Question: Name the type of graph shown.
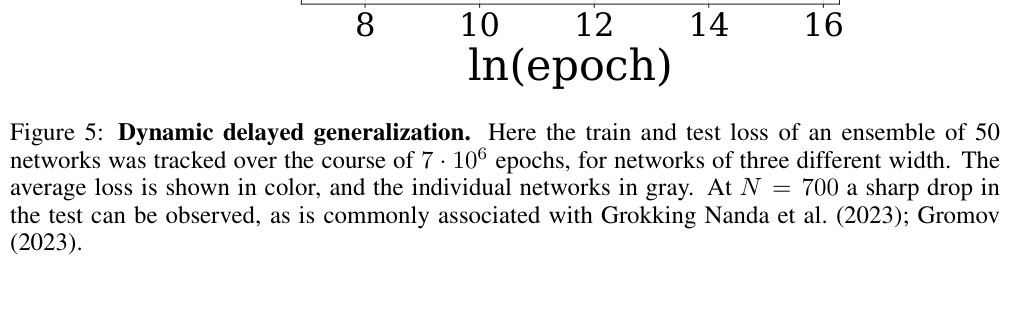
Answer: line